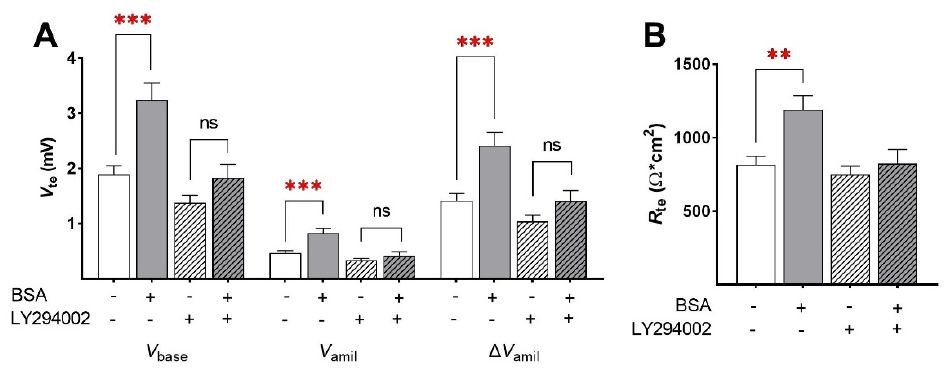
Figure 8. PI3K inhibition prevents the BSA-induced increase in Na + transport. FDLE cells were cultured in MEM, stimulated with BSA (1.0 g/L) and LY294002 (10 µM) for 24 h. Data are displayed as mean + SEM. ( A ) BSA significantly increased V base , V amil , and Δ V amil , while LY294002 prevented the BSA-induced increase (n = 39–46; *** p < 0.001 by t -test; ns = non-significant). ( B ) BSA further significantly elevated R te in FDLE cells, which was prevented by LY294002 (** p < 0.01 by t -test).